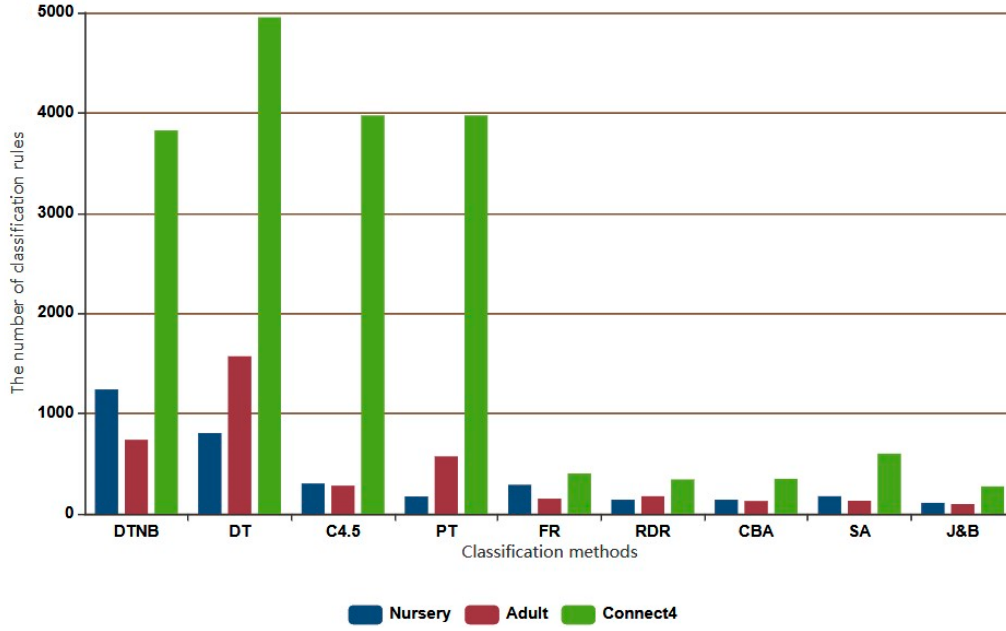
Figure 2. Comparison of rule-based classification methods on the average number of rules.